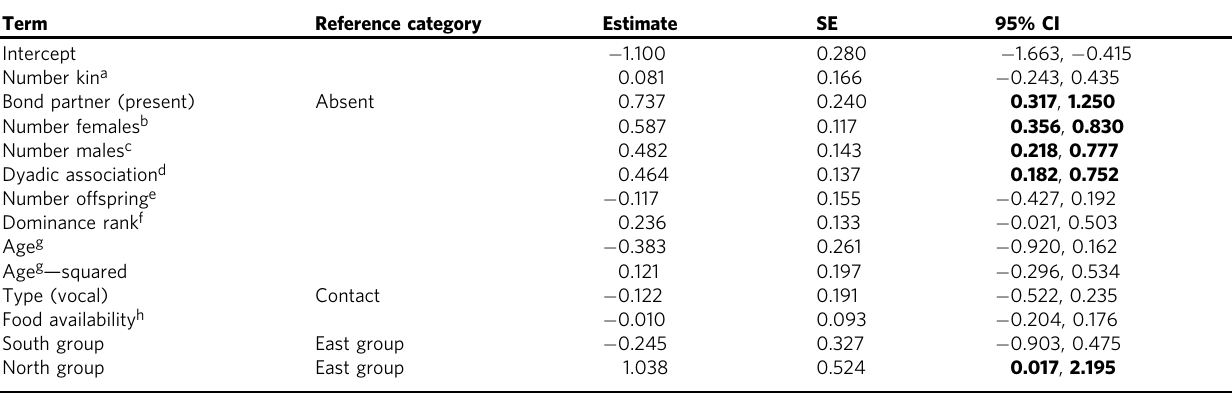
Table 3 Second ‘ Male participation ’ GLMM testing the effect of strength in numbers and predictability of coalitionary support on participation likelihood (Here, the number of living maternal kin is included instead of adult maternal kin presence in the encounter. N = 342 encounters, 36 male